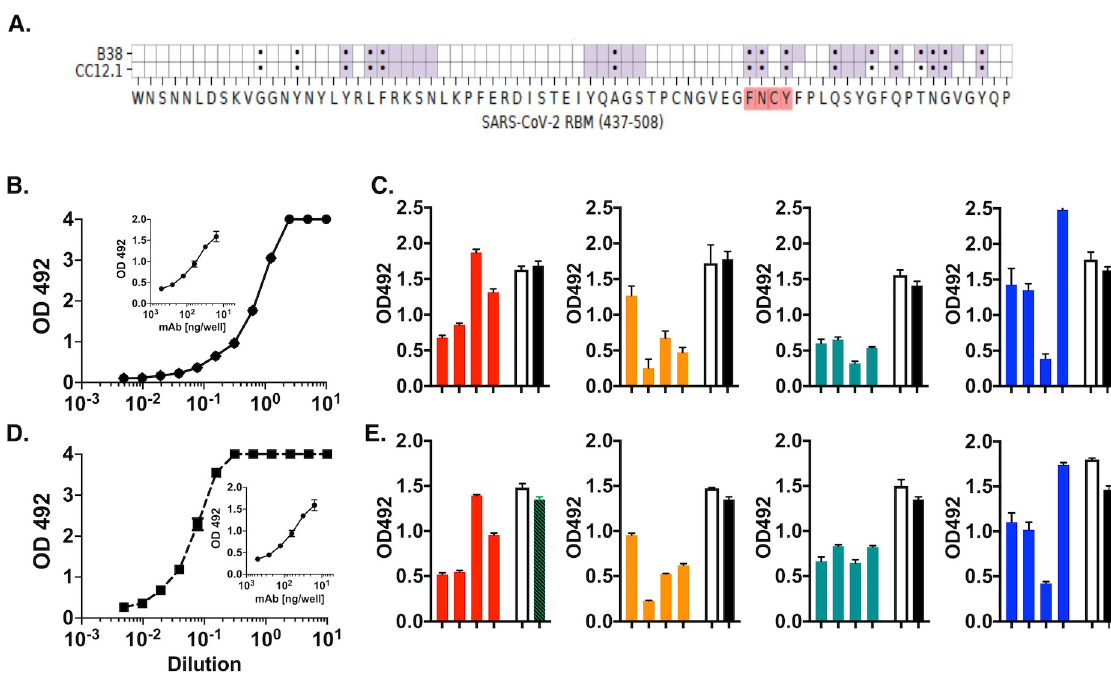
Fig 3. Polyclonal antibodies in immune sera share paratope specificity with Class 1 human neutralizing antibodies B38 and CC12.1. Immune sera were tested in a cross-competition RBD binding assay by ELISA. ( A ) Heatmap of neutralizing antibody contact residues (purple) with RBM region (positions 437–508). Black dots indicate ACE2 contact residues. ( B ) Titration of binding of HRP-B38 to RBD in ELISA. Inset: Slope of inhibition of HRP-B38 binding by unlabeled antibody B38. Effective 50% binding concentrations were (~1.5 ng/well). ( C ) Binding of HRP-B38 in the presence of 1:50 dilution of individual mouse serum (day 45). ( D ) Titration of binding of HRP-CC12.1 to RBD in ELISA. Inset: Slope of inhibition of HRP-CC12.1 binding by unlabeled antibody CC12.1. ( E ) Binding of HRP-CC12.1 in the presence of 1:50 dilution of individual mouse serum (day 45). Empty columns; pre-immune sera. Black columns indicate maximal binding of HRP- labeled antibody in ELISA buffer. Color scheme: red = group 1; orange = group 2; green = group 3; blue = group 4.